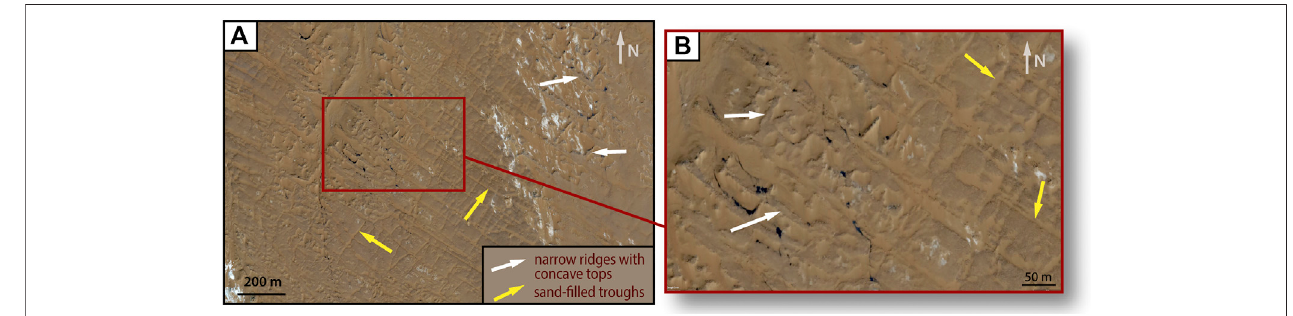
FIGURE 13 | (A) Extensive bedding-plane exposure of pale-brown siliceous limestone with a rectilinear network of shallow, mostly sand- fi lled troughs oriented NW – SE and NE – SW (yellow arrows) and narrow ridges (white arrows) with the same orientations. (B) Zoomed-in view shows that ridges have concave tops and are eroded remnants of what underlies the sand- fi lled troughs, suggesting that the rectilinear pattern is a network of shallow sags in the siliceous limestone layer. Satellite imagery source: Google Earth. Coordinates for Google Earth images: A) 26.077868, 30.444569; B) 26.078738,